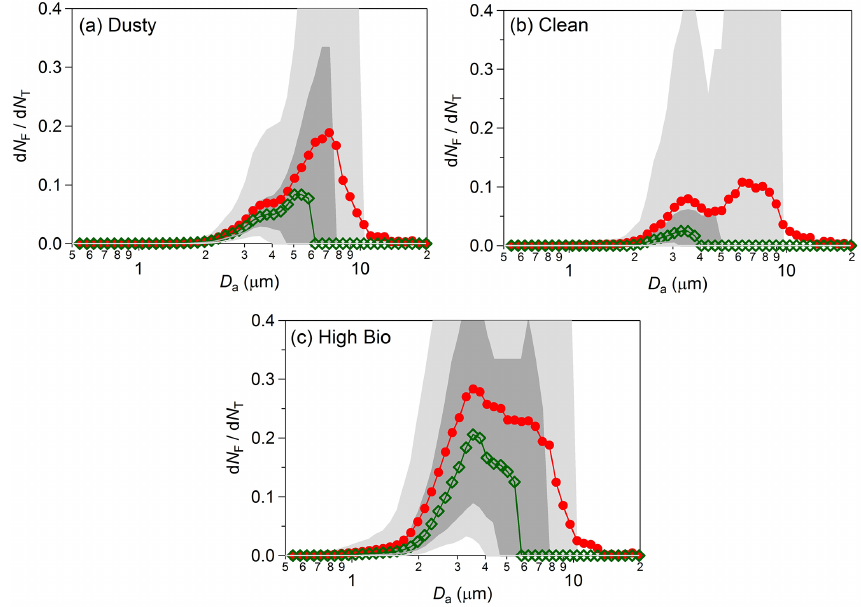
Figure 9. Size distribution of the FBAP to TAP ratio averaged over each distinct focus period during the measurements carried out at Munnar (d N F / dlog D a = d M F / dlog D a ) . The lower and upper parts of the dark and light shaded areas represent the 5th, 25th, 75th, and 95th percentiles, respectively: (a) dusty, (b) clean, and (c) high